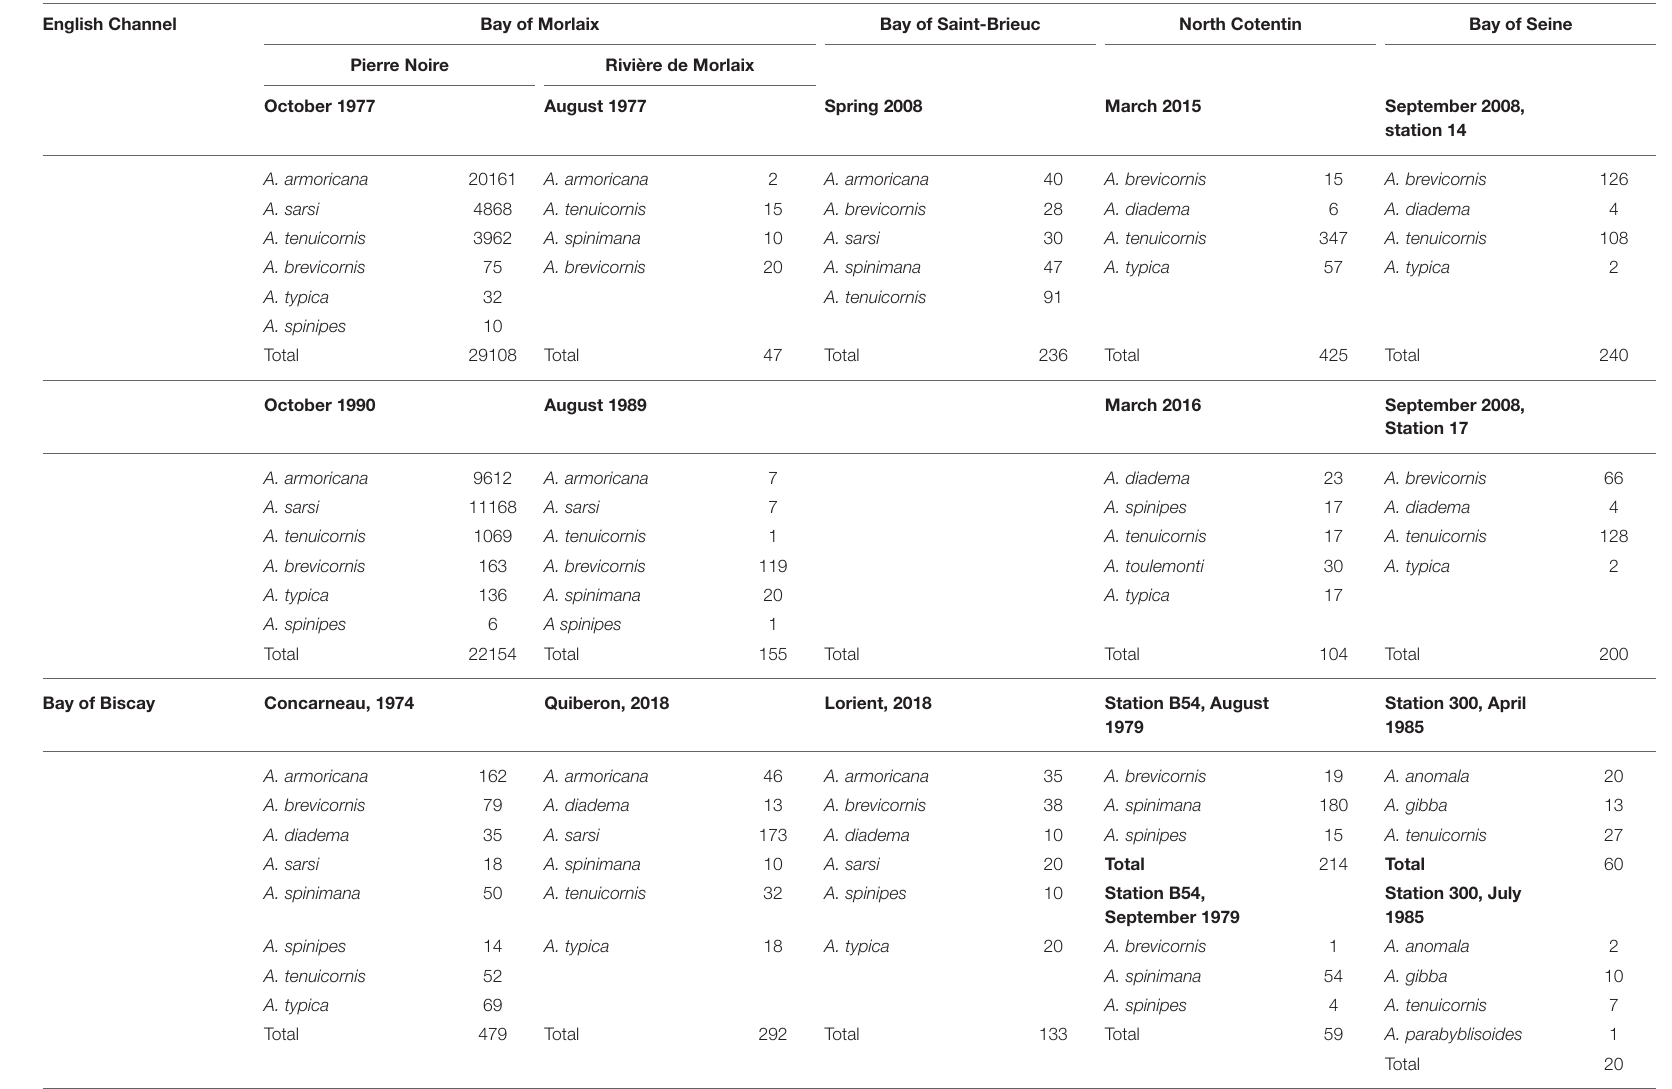
TABLE 3 | Abundance of Ampelisca species in number of ind. m ² in some stations where the species were in sympatry from the English Channel, Bay of Biscay and Portugal coasts. English